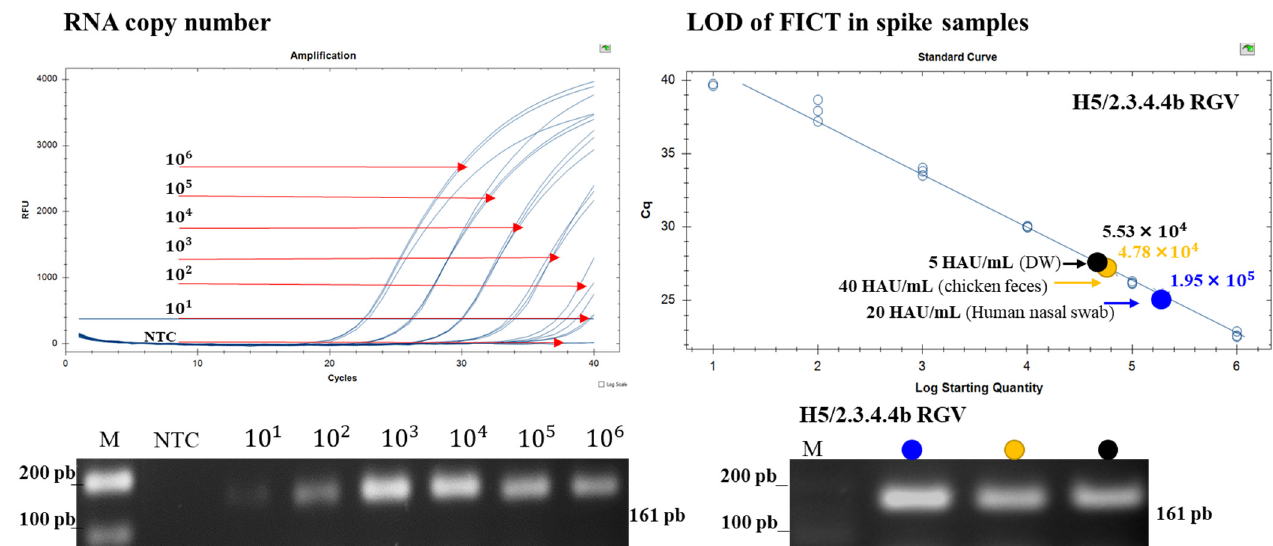
Figure 7. Assessment of FICT performance by RT-PCR. The linear relationship between Ct and RNA copy number is shown. The bottom panel shows the PCR products of different RNA standards and diluted virus for LoD determination (5 μ L sample/lane); target bands were obtained at 161 base pairs (bp). The red arrows indicate the point corresponding to the RNA copy number and the color dots correspond to the LoD of the virus titer in the different samples. NTC, no template control. Raw RT-PCR data are shown in Supplementary Figure S8.